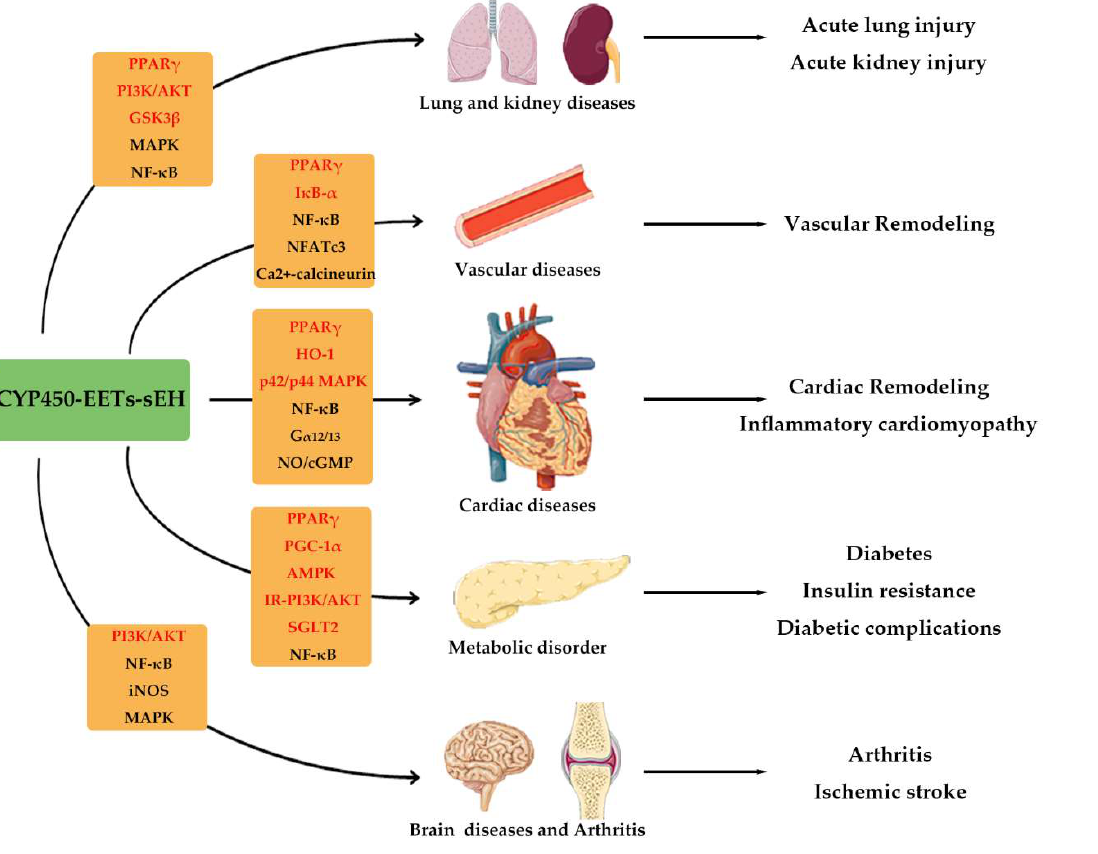
Figure 11. The major signaling pathways and beneficial effects of CYP450-EETs-sEH system in inflammatory-related diseases. EETs attenuate vascular inflammation and remodeling by regulating PPARγ, NF-κB/IκB-α, NFATc3, mitoK ATP , and Ca 2+ -calcineurin. EETs also process direct and indirect anti-inflammatory properties in the myocardium, and therefore alleviate inflammatory cardiomyopathy and cardiac remodeling. The related molecular mechanisms including PPARγ, NF-κB, HO-1, Gα12/13, NO/cGMP, and p42/p44 MAPK. Moreover, EETs play substantial roles in relieving inflammation under other pathophysiological environments, such as diabetes, sepsis, lung injuries, neurological disease, hepatic diseases, kidney injury, and arthritis. The related molecular mechanisms including PPARγ, NF-κB, PI3K/AKT, GSK3β, AMPK, MAPK, et al. For the whole figure, the red represents activation, and the black represents inhibition in the orange textbox.